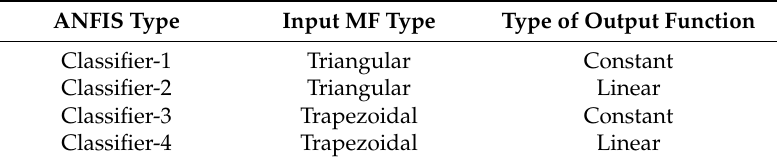
Table 5. Various types of ANFIS classifier.